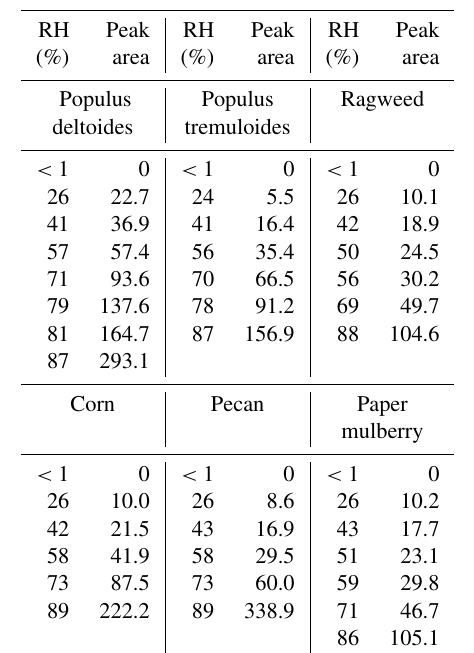
Table 2. Integrated areas of IR peaks (at ∼ 3600cm − 1 ) of ad- sorbed water as a function of RH for the six pollen species investi- gated in this work. Wave number ranges used for integration are 3750–3300cm − 1 for Populus deltoides pollen, 3750–3350cm − 1 for Populus tremuloides pollen, 3750–3400cm − 1 for ragweed pollen, 3750–3500cm − 1 for corn pollen, 3750–3450cm − 1 for pecan pollen and 3750–3300cm − 1 for paper mulberry